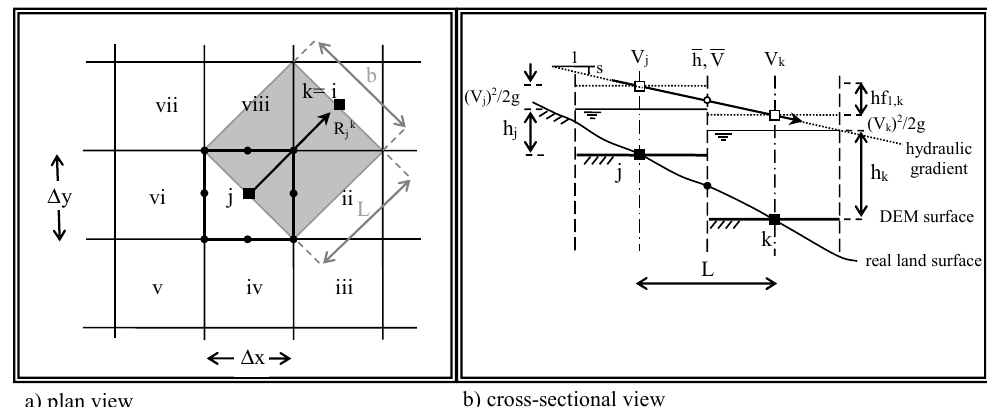
Figure 1. Computation details of the proposed cell by cell processing. ( a ) plan view, ( b ) cross-sectional view.